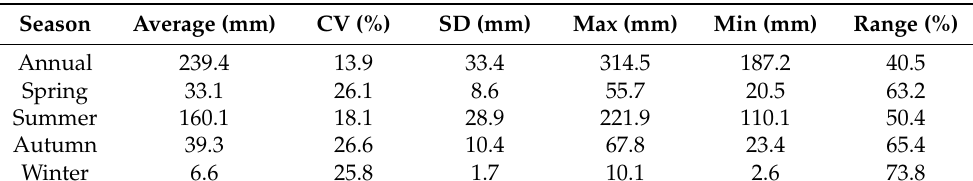
Table 1. The annual and seasonal average precipitation change during 1976–2017 in the Mongolian Plateau.